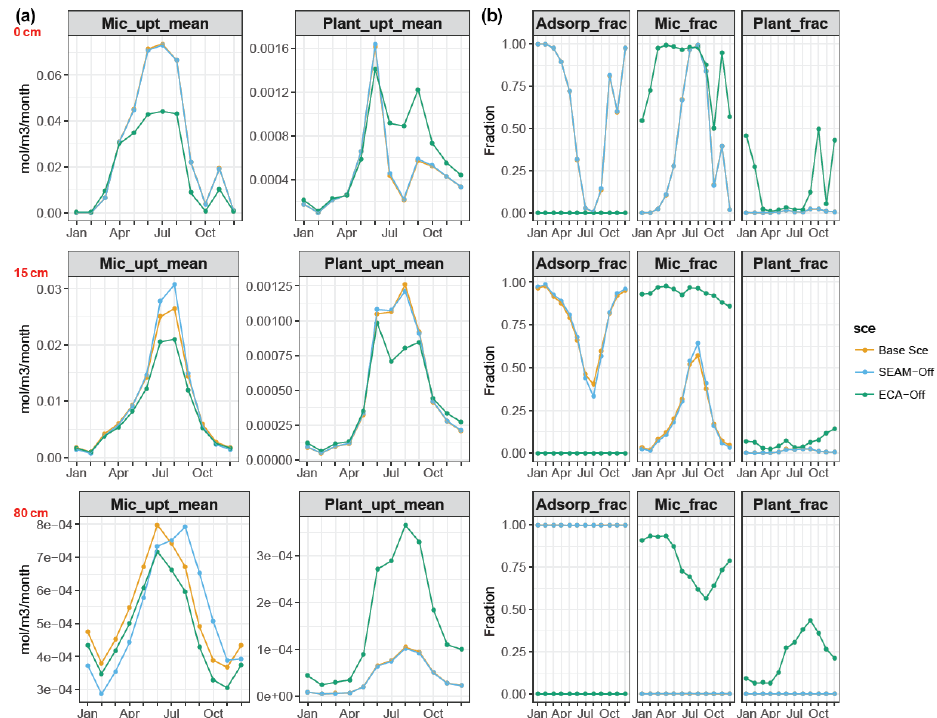
Figure 8. Simulated (a) microbial and plant P uptake rates and (b) relative competitiveness (in fractions) of P adsorption, microbial P uptake and plant P uptake at depths of 0 (O–A horizon, upper panels), 15 (A–B horizon, middle panels) and 80 cm (B–C horizon, bottom panels). In (a) , monthly mean values at different depths are presented throughout the whole year; in (b) , relative competitiveness is calculated as the fraction of the individual rate to the sum of all three rates (P adsorption rate, microbial P uptake and plant P uptake). All data points are derived from data from the last 10 years of model